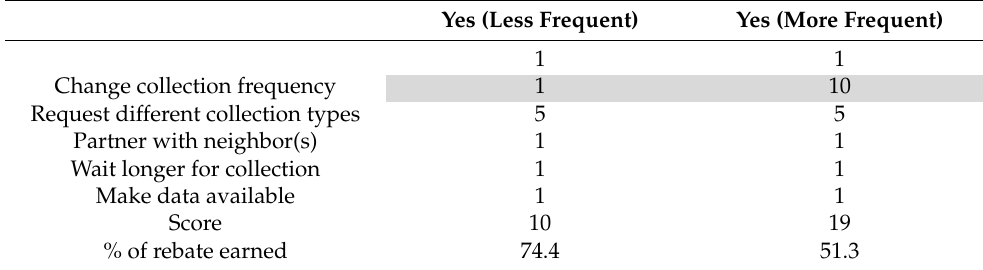
Table 3. Impact of adapting the bin collection